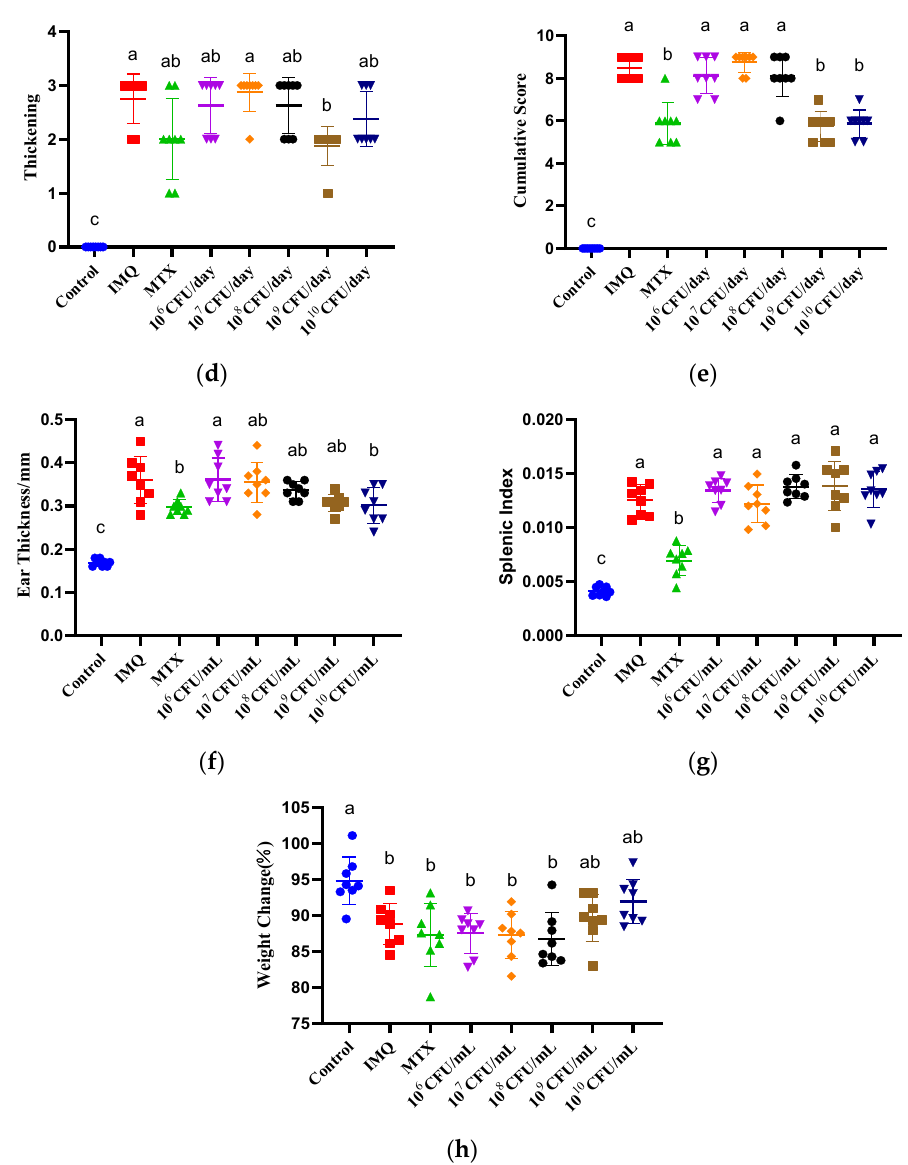
Figure 1. Effect of CCFM683 treatment on IMQ-induced psoriasis. ( a ) Macroscopic pictures of skin lesions. ( b ) Erythema, ( c ) scaling, ( d ) thickening, ( e ) ear thickness, ( f ) cumulative score, ( g ) splenic index, and ( h ) change in body weight (%). n = 8 mice per group. Groups with different letters are significantly ( p < 0.05) different from each other.